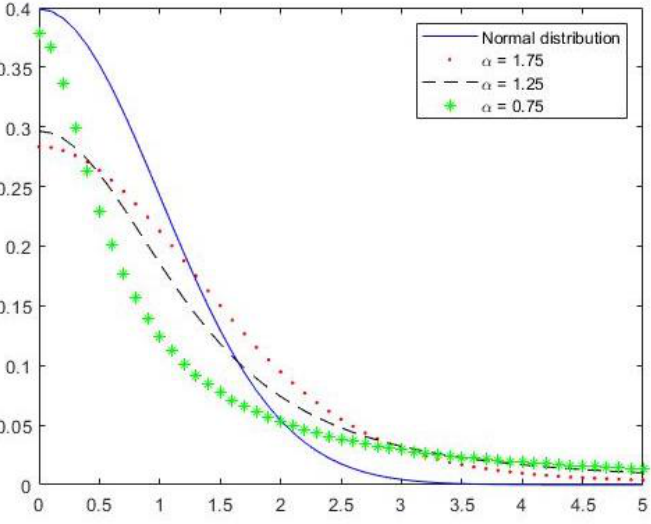
Figure 1. Comparing the tail behavior of Brownian motion of ( α = 2) and Lévy stable of Equation (4) at varying value of α , with m = 0 and σ = 1. It can be observed that the tails get heavier when α